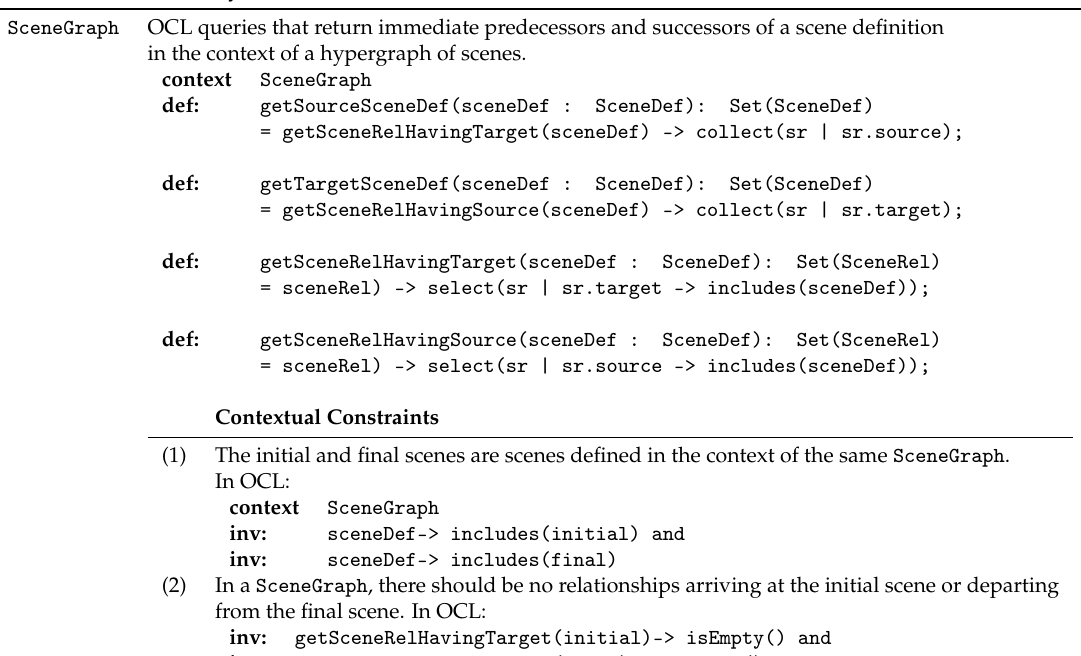
Table 6. Dialogical specification pattern: Contextual